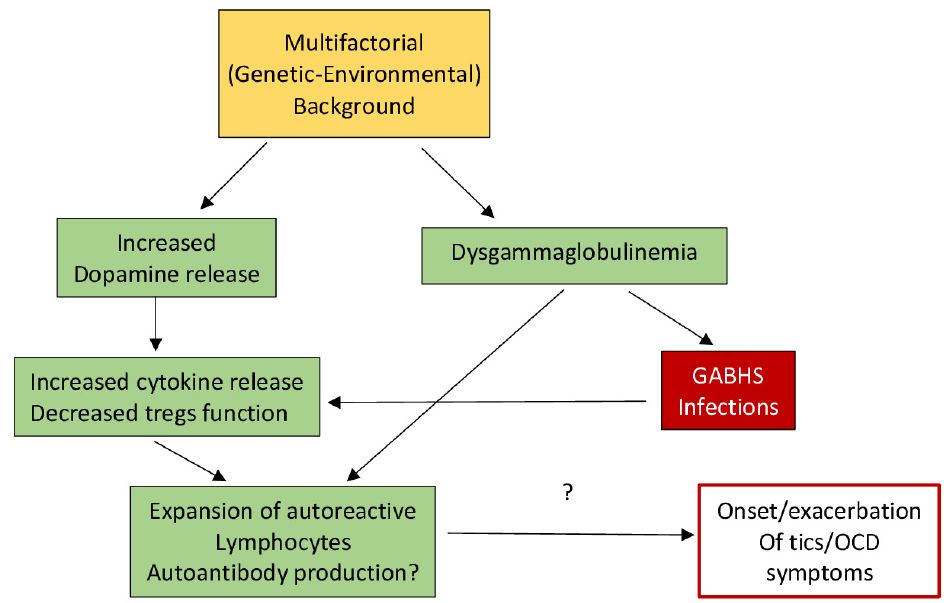
Figure 1. Hypothetical model of the basis for dysfunction in TS. Secondary to the reduction in T regulatory lymphocytes (Tregs), an enhancement of cytokines and reduction in immune tolerance may be facilitated by increased dopamine levels as well as dysgammaglobulinemia, which could possibly facilitate autoimmunity (after Eelamin, I., Edwards, M. J., and Martino, D. (2013). Immune dysfunction in Tourette syndrome. Behavioural neurology , 27 (1), 23–32. with